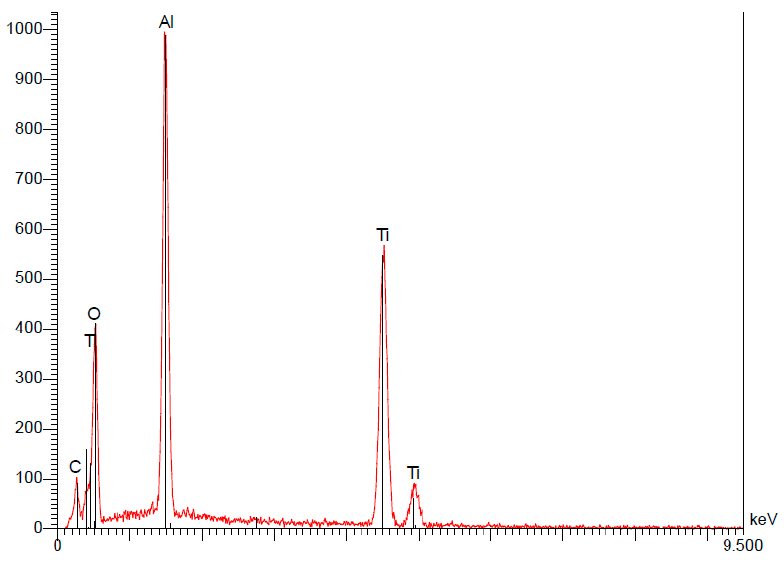
Figure 8. Spectroscopy of the Ikone ® implant. Table 6. The quantitative results of the EDS analysis of the Inkone ® implant demonstrating weight percentages (P%) and atomic percentages (A%) of the elements detected.